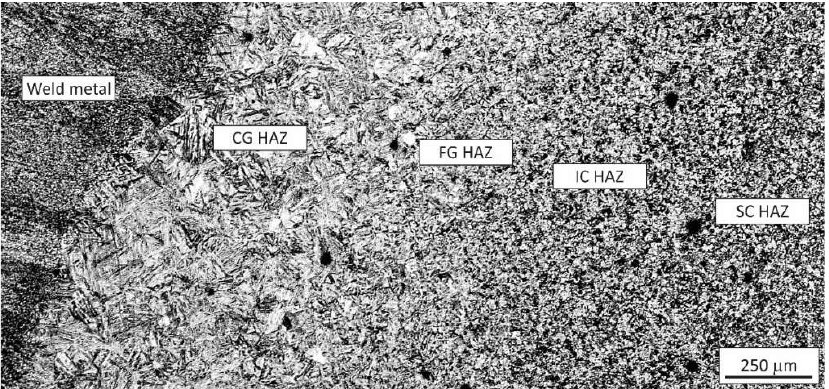
Figure 5. Microstructures in the real-weld joint (from left to right): weld metal, CG HAZ, FG HAZ, IC HAZ, and SC HAZ. IC HAZ, and SC